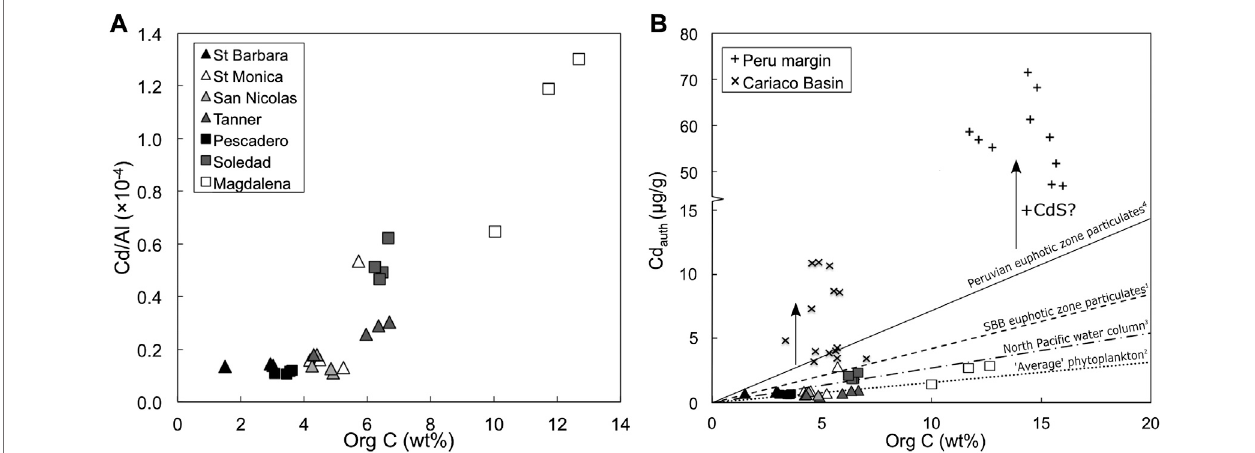
FIGURE 4 | (A) Positive covariation of sedimentary Cd/Al with organic carbon concentrations. (B) Bioauthigenic Cd auth concentrations ( Eq. 3 ) versus organic carbon concentrations for sediment samples in this study (triangles and squares) to sediments from the Peruvian ODZ (+) and the euxinic Cariaco Basin (x) (data: Little etal.,2015).Forcomparison,thedashedlinegivestheaverageCd:CratiofromeuphoticzoneparticlesintheSantaBarbaraBasin(1:Bourneetal.,2018),thedottedline shows Cd:C ratio in ‘ average ’ phytoplankton (2: Ho et al., 2003), the dot-dashed line shows the Cd:C ratio estimated for the North Paci fi c from an analysis of dissolved Cd and P concentration data (3: Quay et al., 2015), and the solid line shows the Cd:C ratio in euphotic zone particles from the Peru margin (4: 7.66 × 10 − 6 ; Bourne et al., 2018). Schematic vertical black arrows represent the proposed impact of CdS precipitation on sedimentary Cd auth concentrations.